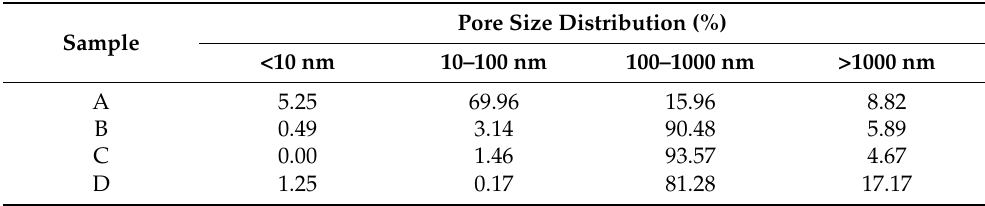
Figure 7. ( a ) Total porosity, ( b ) Open porosity, ( c ) Closed porosity of porous alumina measured using different testing methods. Table 2. Pore structure parameters of porous alumina obtained by MIP.